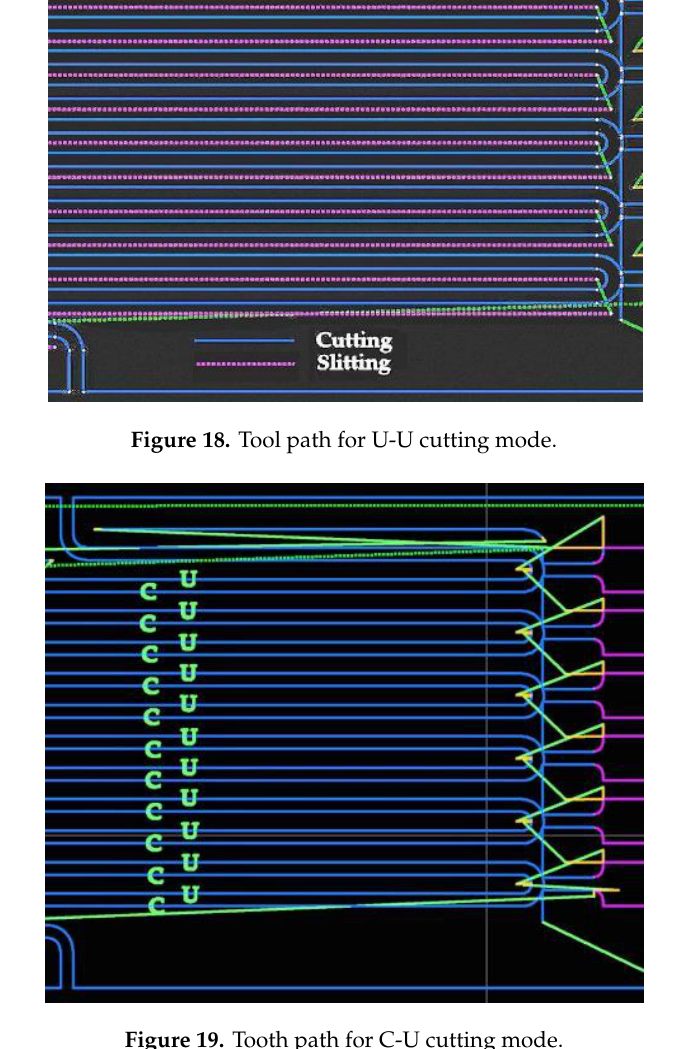
Figure 18. Tool path for U-U cutting mode.